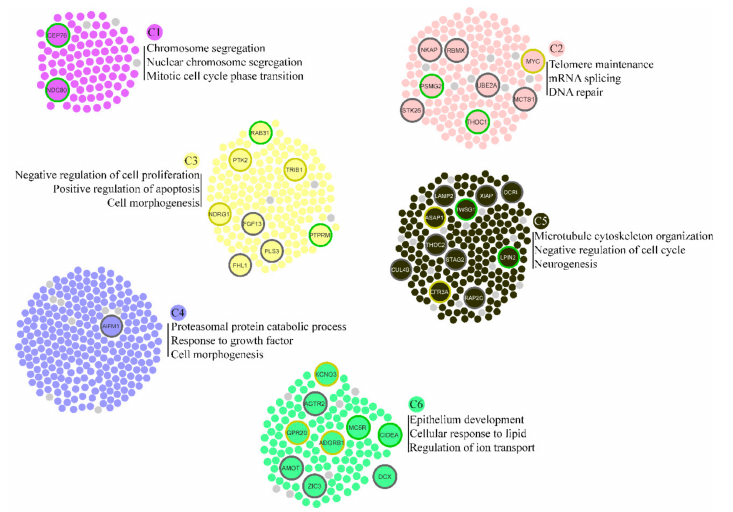
Figure 2. Functional cluster detection in eDSi. Node border colors represent the origin of duplication: dup 8q24.13q24.3 in yellow; dup 18p11.32p11.21 in green; dupXq22.3-q27 in grey. Small nodes in light grey represent